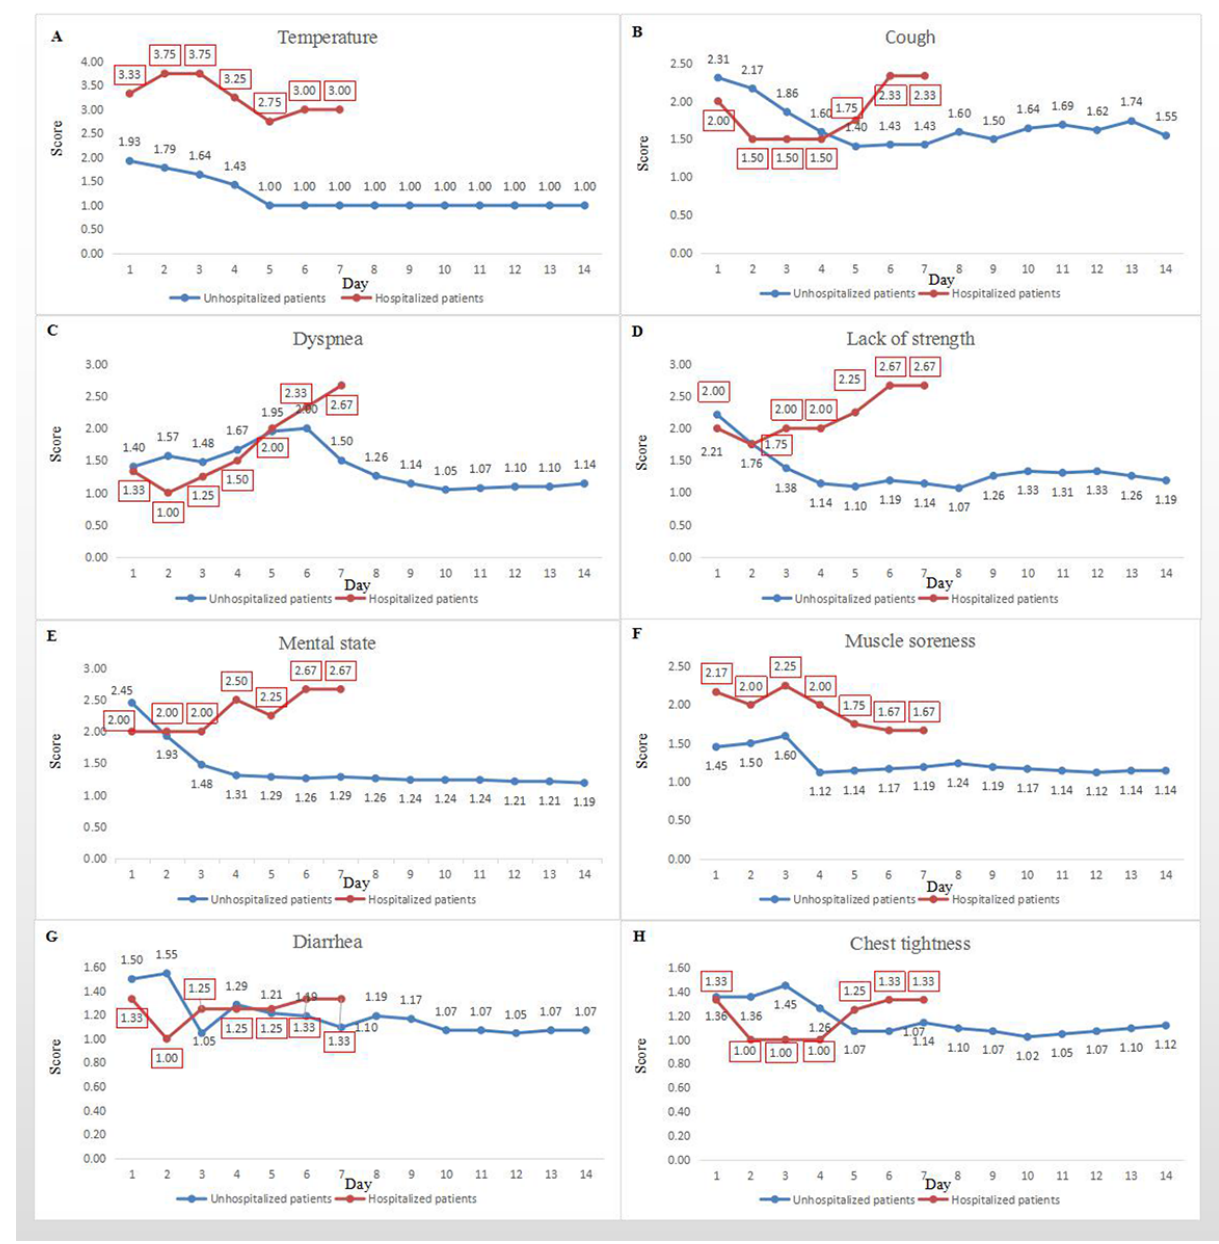
Figure 6. Comparison of symptom trends between non-hospitalized and hospitalized